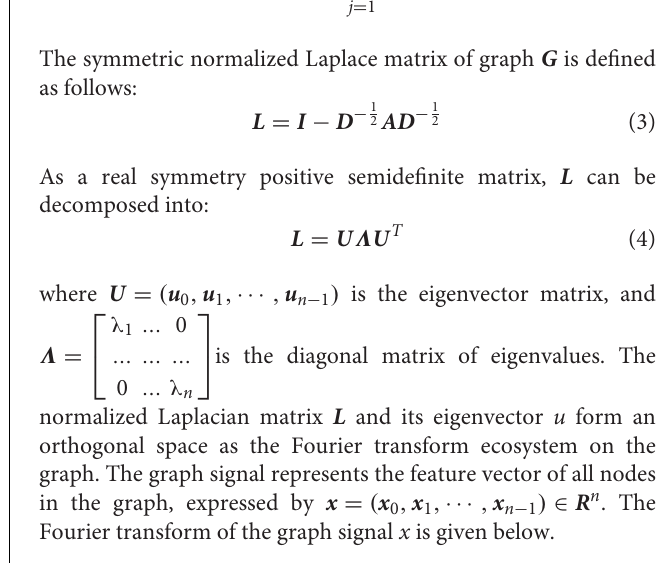
FIGURE 2 | Statistics of published graph neural network (GNN) articles in bioinformatics from 2015 to 2020. The orange bar shows the total number of GNN papers in bioinformatics that year (note: the number of papers in 2020 is counted until October). The remaining colors, in turn, represent the number of papers related to GNNs in bioinformatics in terms of disease association prediction, drug research, and medical image processing, which are the components of the orange